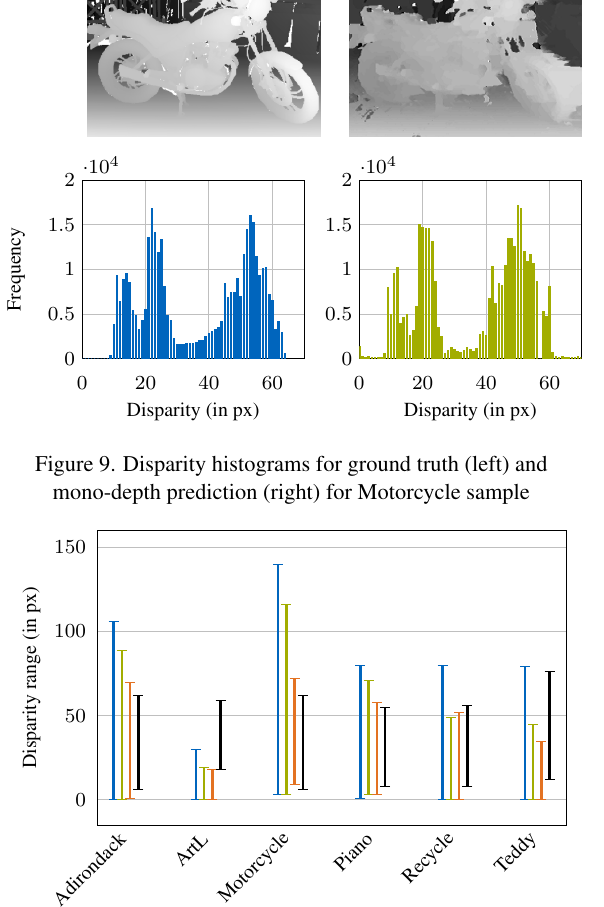
Figure 10. Comparison of disparity range estimation for raw pixels ( ), 9x9 median filter ( ), and histogram-based ( ) w.r.t. the ground truth disparity range (